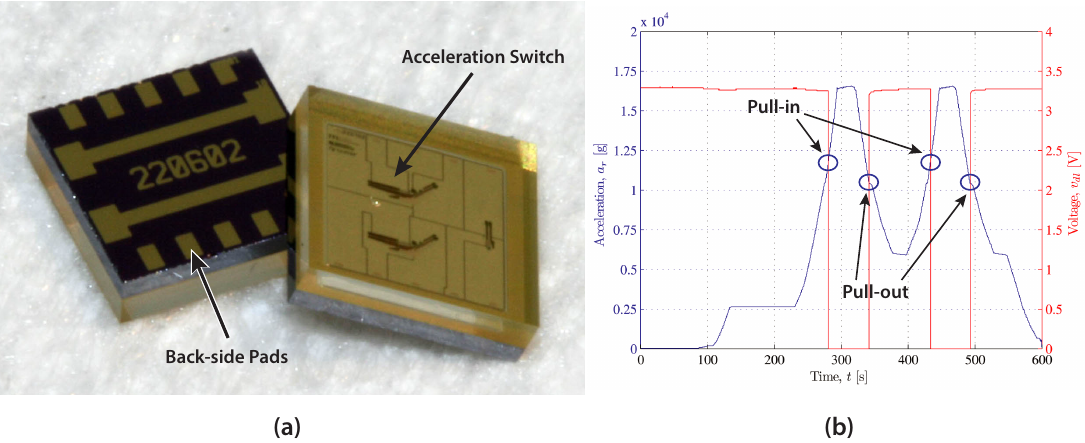
Figure 5. ( a ) Fully fabricated acceleration switch, showing the metal pads on the back-side ( left ) and the glass-encapsulated acceleration switch on the front-side ( right ); ( b ) Measurement result, displaying correct switching behavior with a pull-in acceleration of 11,800 g and a pull-out acceleration of 10,500 g . Originally distributed at the International Wafer-Level Packaging Conference, Santa Clara, CA, USA; 3–6 October